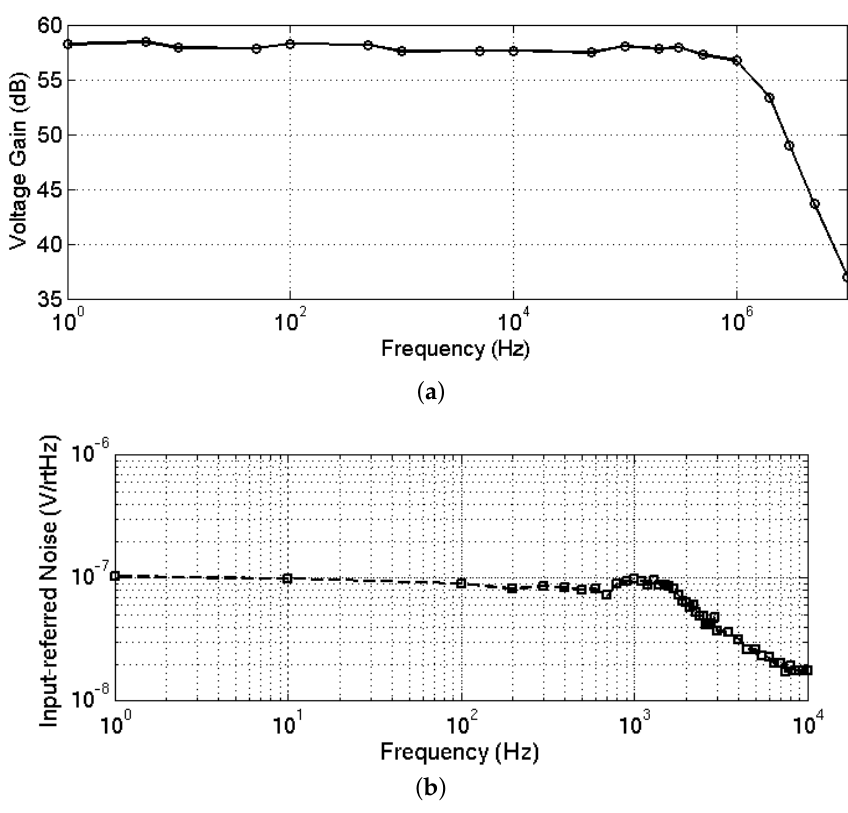
Figure 11. Measured system ( a ) frequency response; and ( b ) input-referred